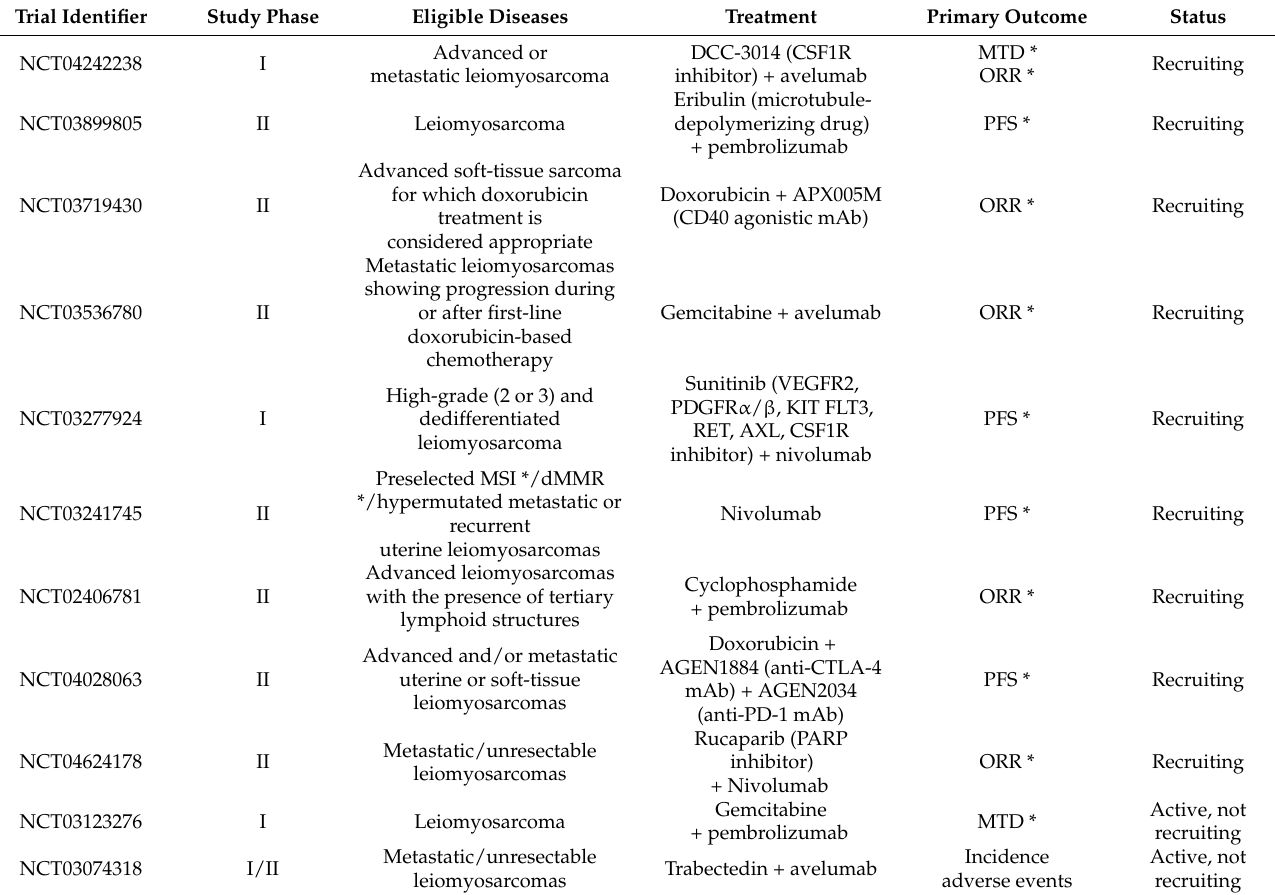
Table 1. Currently, active clinical trials testing combinations of targeted therapy or chemotherapy with immunotherapy in LMS, including